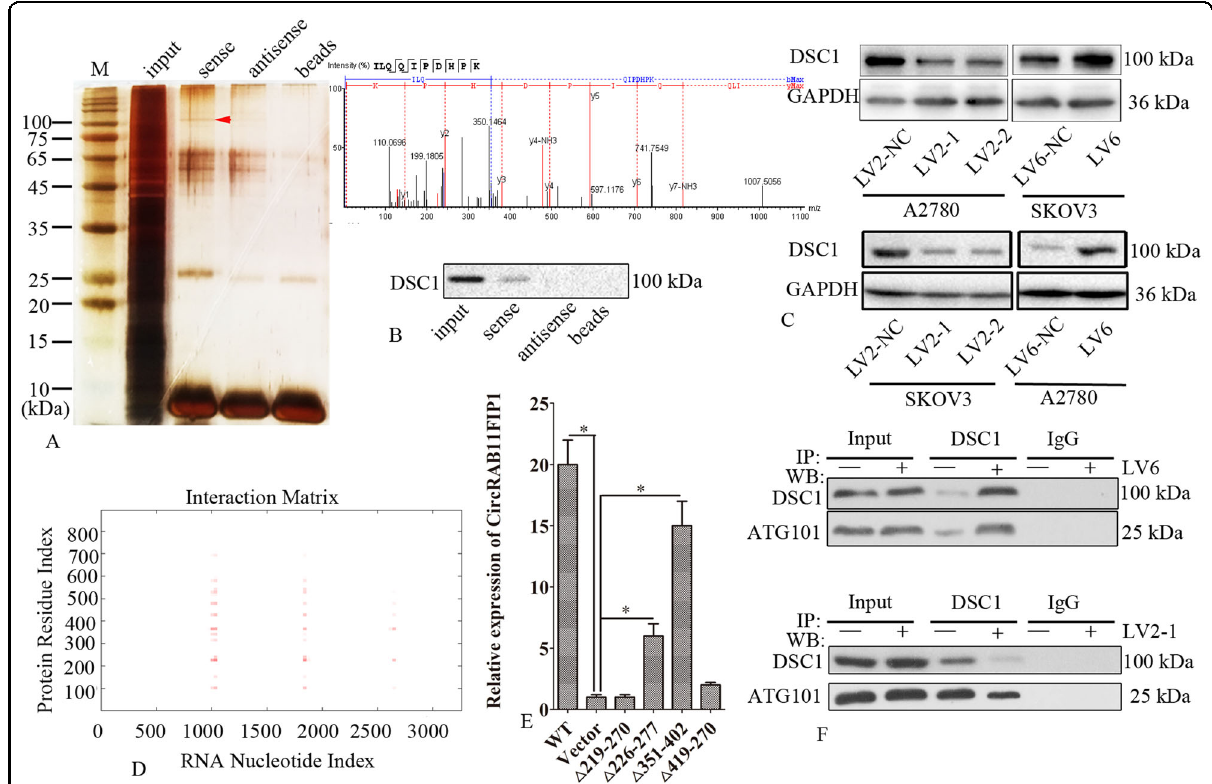
Fig. 7 CircRAB11FIP1 directly bound to DSC1 protein. A Silver staining of protein gels acquired through circRAB11FIP1 RNA knockdown. B RNA knockdown was applied to identify circRAB11FIP1-speci fi c binding protein gels. C LV2, LV2-1, or LV2-2 was transfected into SKOV3 and A2780 cells. LV6-NC or LV6 was transfected into SKOV3 and A2780 cells. Later, the DSC1 protein level was detected through western blot analysis. D catRAPID was used to predict possible binding sites between circRAB11FIP1 and DSC1 protein. E DSC1 DNA fragments were cloned to the PCMV5 plasmid. PCMV5 vector, PCMV5-DSC1, PCMV5- Δ 26-77, PCMV5- Δ 139-190, or PCMV5- Δ 176-227, PCMV5- Δ 239-290 was transfected into SKOV3 cells. PCR was conducted to detect circRAB11FIP1 expression after 48 h. F Co-IP and western blot assays showing the interaction between DSC1 and ATG101 in SKOV3 and A2780 cells stably transfected with LV6 or LV2-1, respectively. Error bar stands for standard error. * P < 0.05; ** P <